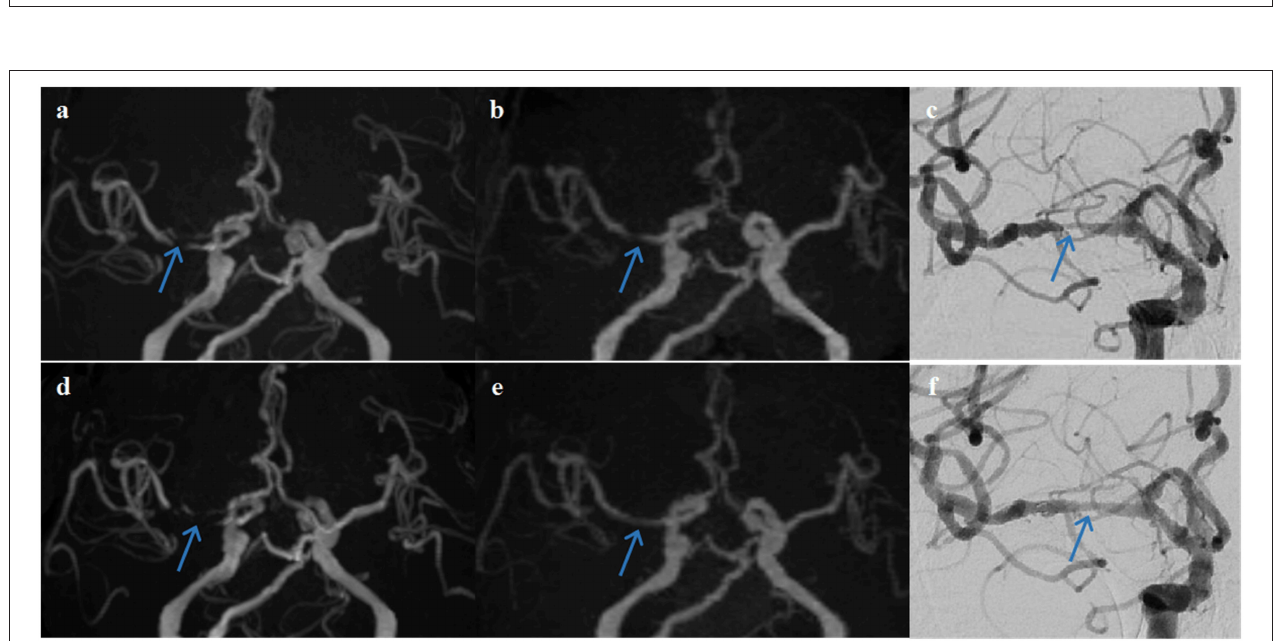
FIGURE 5 | A representative case of a 68-year-old female patient who underwent stent angioplasty due to atherosclerotic stenosis of the right middle cerebral artery (MCA) at the M1 segment (blue arrows). Pre-intervention images are shown on the top row (a) TOF-MRA, (b) PETRA-MRA, and (c) DSA. The degree of stenosis was 100% on TOF (pseudo-occlusion), 79.8% on PETRA-MRA, and 86.3% on DSA. Image quality scores of the PETRA-MRA and 3D-TOF were 4 and 3, respectively. Post-intervention images are shown on the bottom row (d) 3D-TOF, (e) PETRA-MRA, and (f) DSA. Post-intervention TOF-MRA had strong signal loss near the stent, and post-intervention PETRA-MRA had minimal signal loss near the stent comparing with reference DSA. PETRA-MRA had significantly higher image quality scores than those of TOF-MRA considering flow visualization within the stents (PETRA-MRA, 4; 3D-TOF, 1) and susceptibility artifact (PETRA-MRA, 4; 3D-TOF, 1).